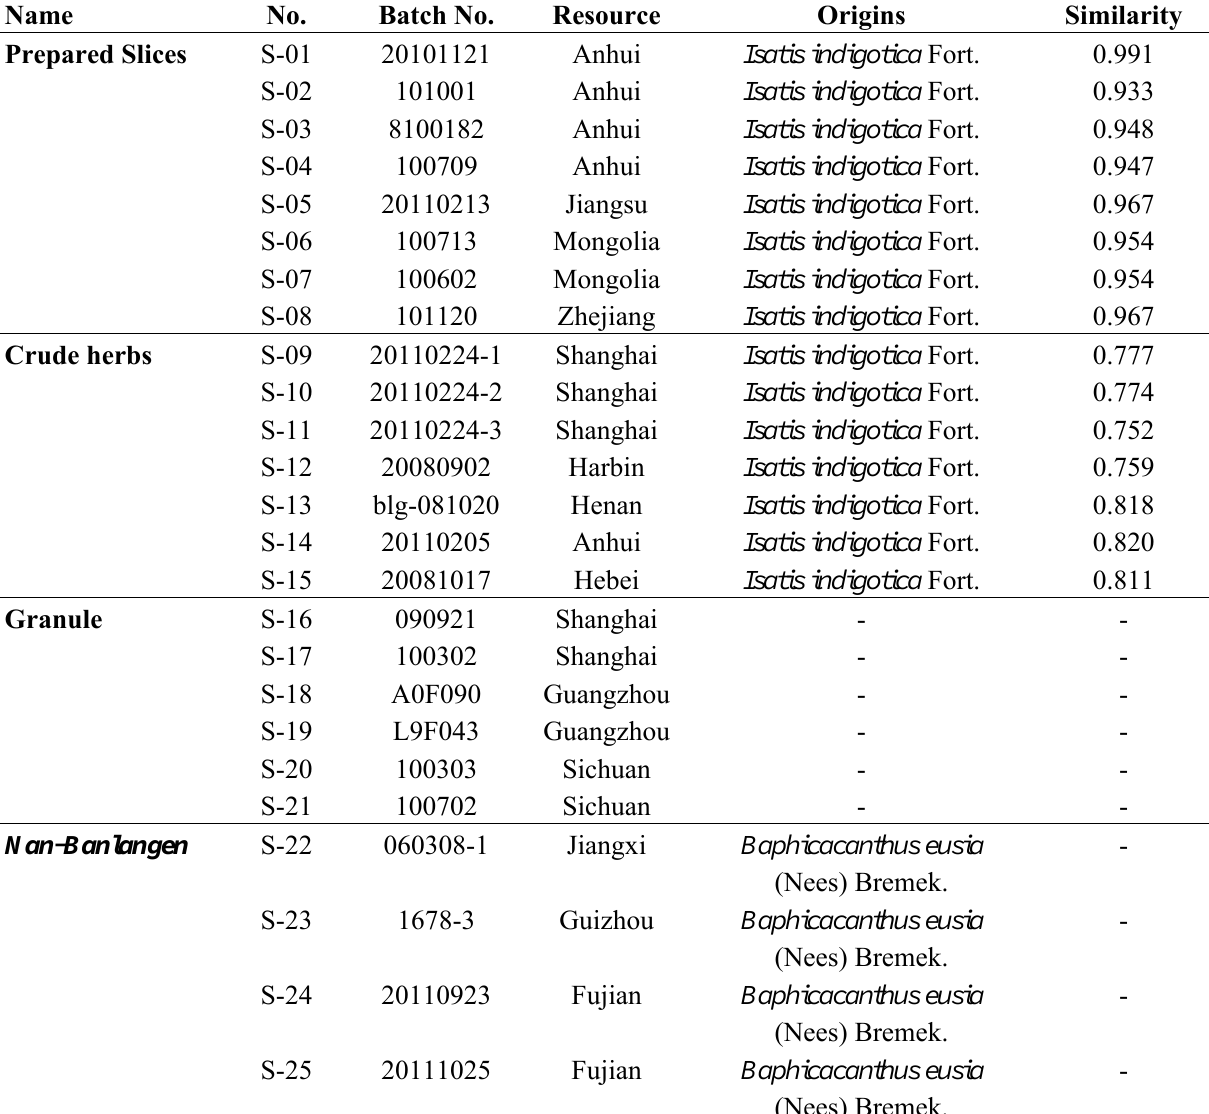
Table 4. All samples used in this work and their corresponding